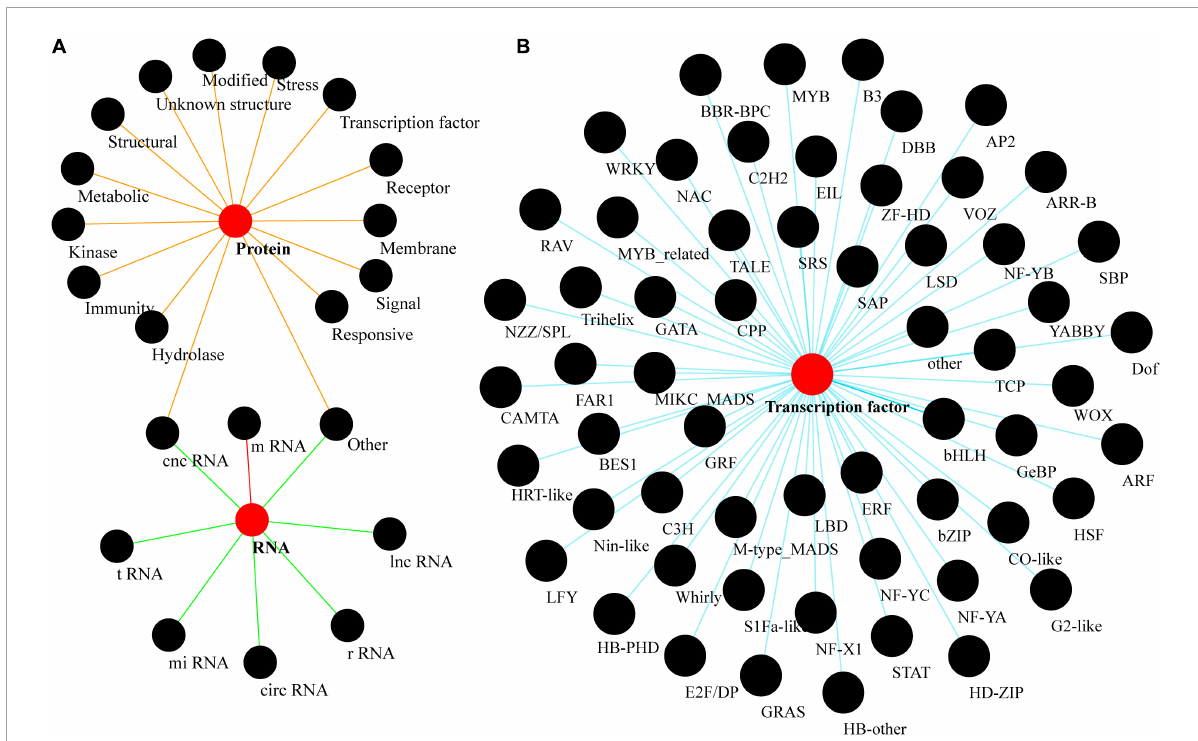
FIGURE2 Plant gene families. (A) A brief classification of gene families found in plants. (B) A rich taxonomy of plant transcription factors. tRNA is an RNA composed of 76–90 nucleotides that carry amino acids into the ribosome and synthesize proteins under the guidance of mRNA; lnc RNA is a class of non-coding RNA molecules longer than 200 nt; mi RNA is a class of endogenous, small RNAs of about 20–24 nucleotides in length; circ RNA is a class of RNAs that do not have a 5 (cid:48) terminal cap and 3 (cid:48) terminal poly(A) tail, and are covalently bonded to form a loop structure; they are a class of non-coding RNA molecules that are found in living organisms. cnc RNA (coding and non-coding RNA) is a family of functional genes that can be differentially sheared in a variable manner, resulting in both short peptides or small molecular weight proteins and untranslatable functional RNAs (e.g., Inc RNA, mi RNA,